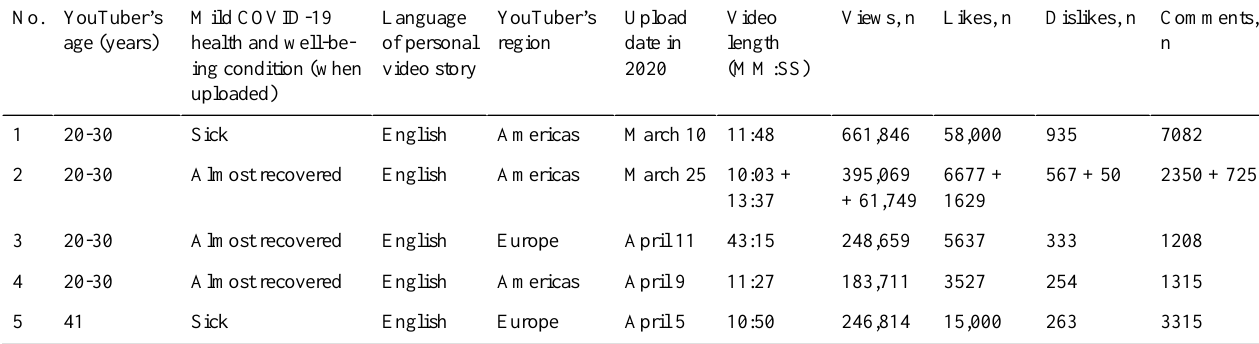
Table 1. Sample of personal video stories and comment threads.